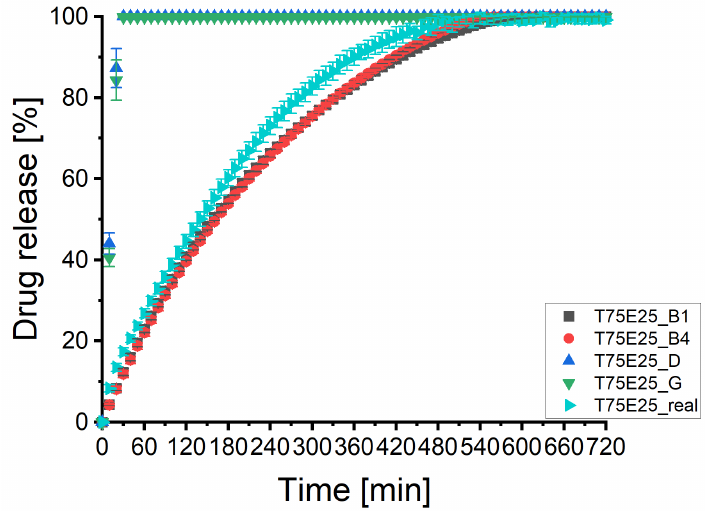
Figure 8. The predicted dissolution profiles of two image processing pathways of the imaged tablets 1, 3, and 5 of batch T75E25 ( ¯ x SD , n = 3). The experimental determined dissolution profile is depicted as well.